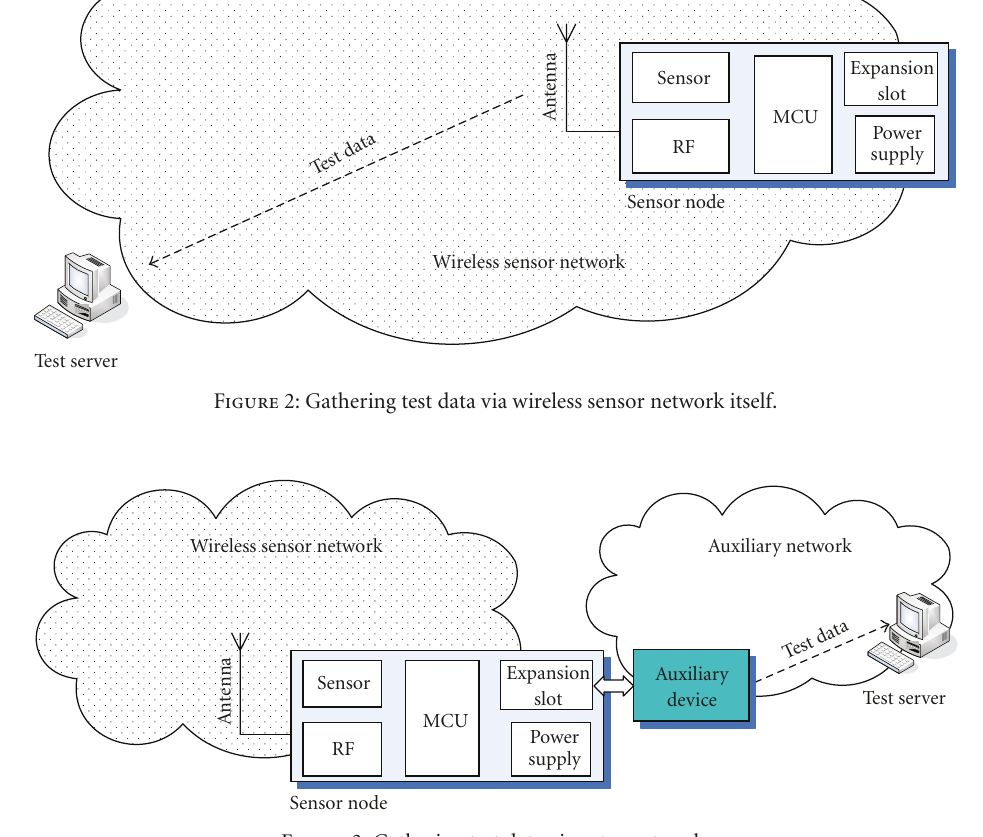
Figure 3: Gathering test data via extra network.